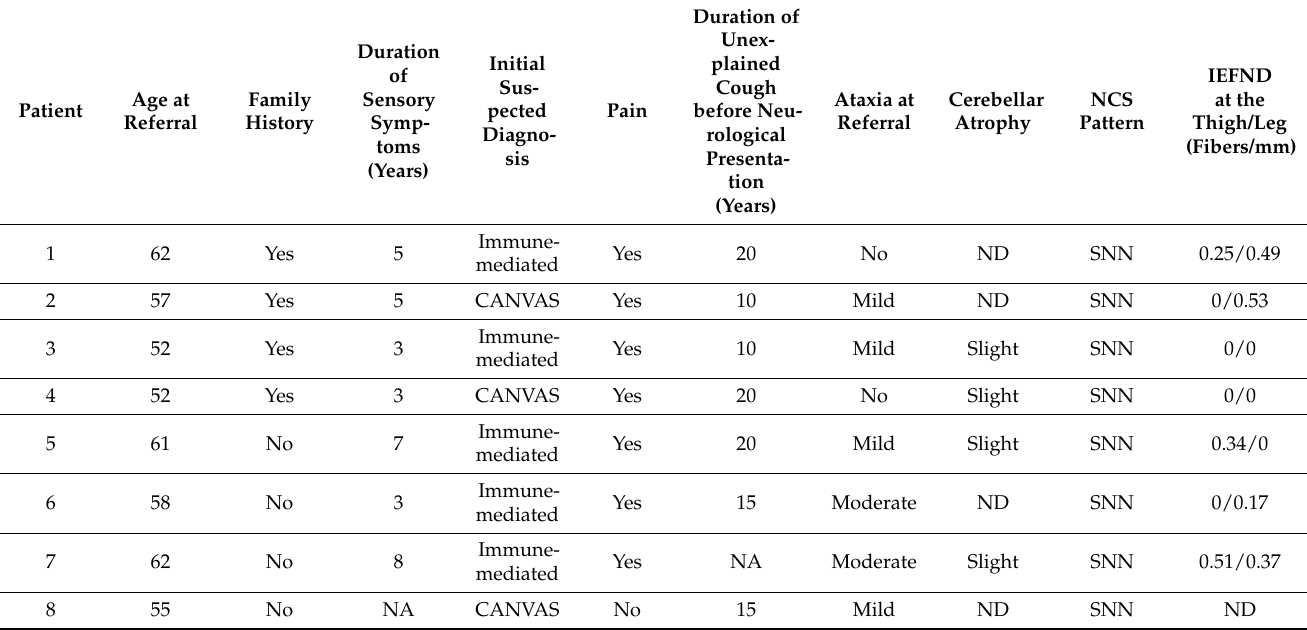
Table 1. Main clinical and laboratory features at referral of eight female patients with